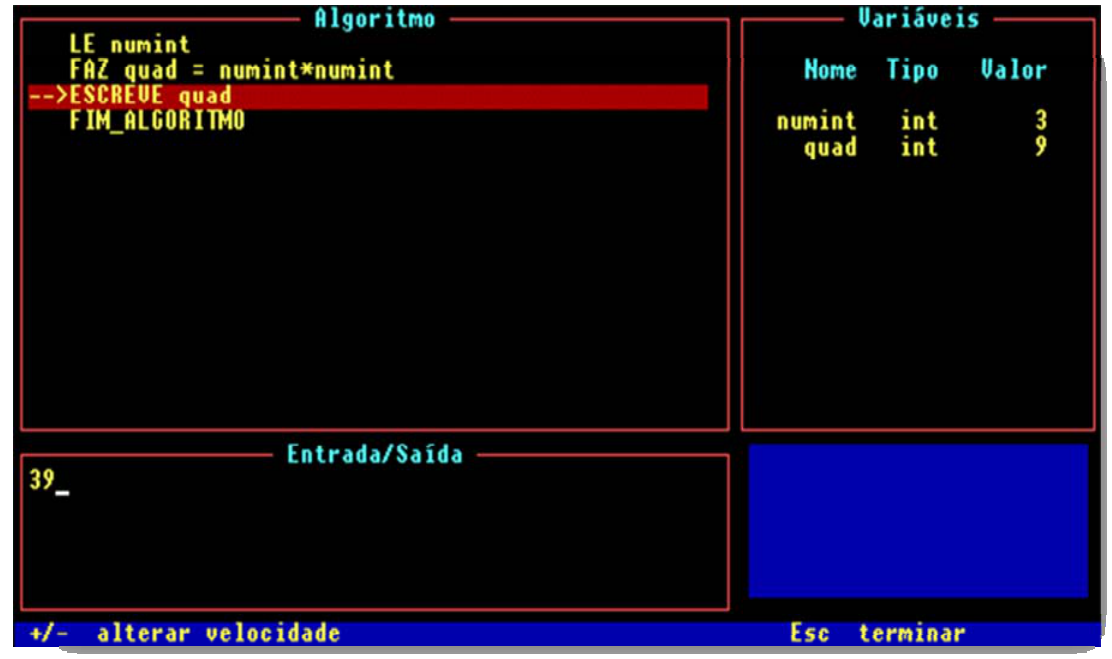
Figure 1. The VIP